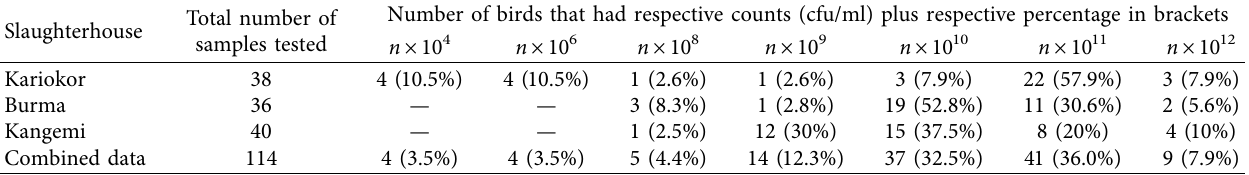
Table 1: Number of chickens that had the respective total bacterial concentration.